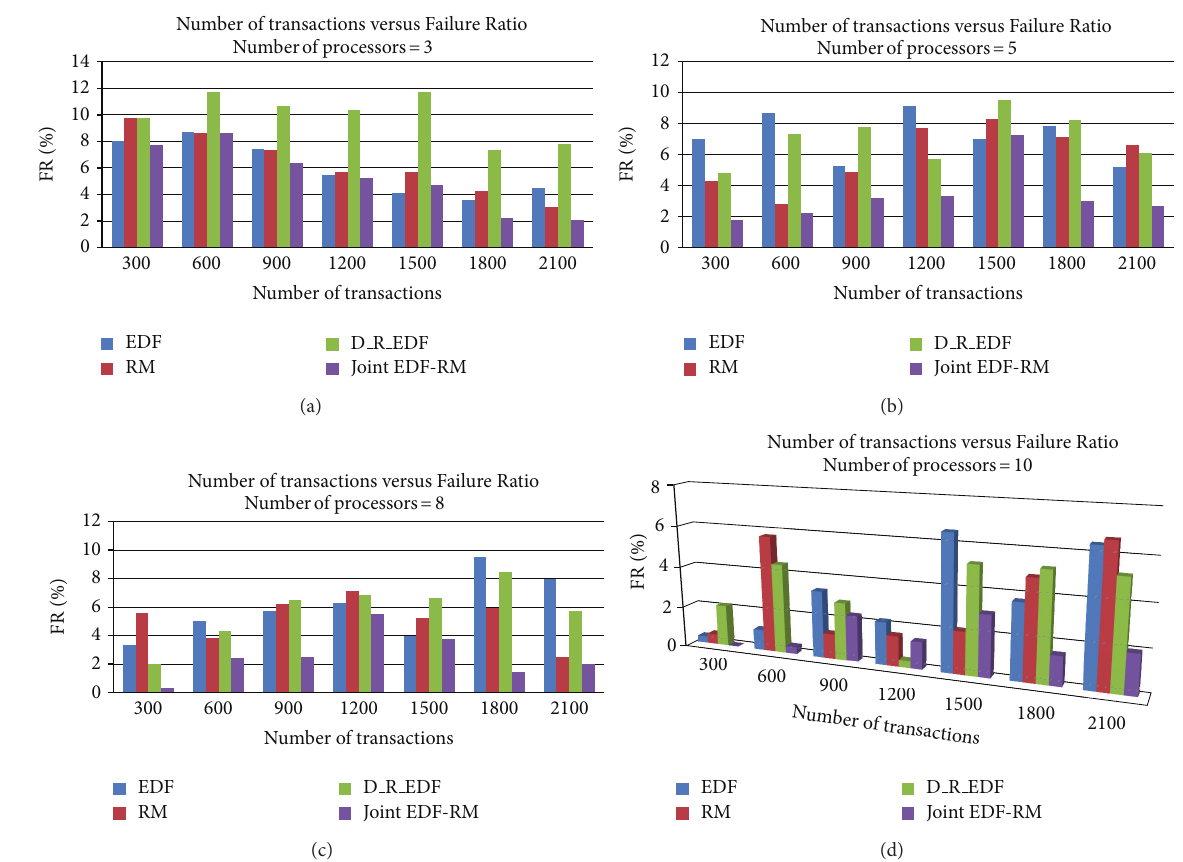
Figure 12: Number of transactions versus Failure Ratio on 3, 5, 8 and 10 processors.